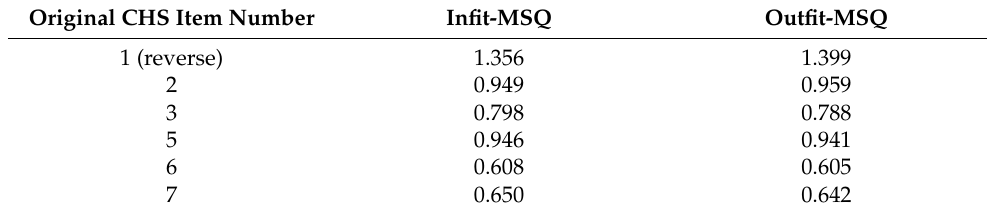
Figure 3. Plot of the standardized residuals. The y -axis shows values of the standardized residuals for each item, and the x -axis shows the persons ordered by their identification number. Table 3. Infit-MSQ and outfit-MSQ of each